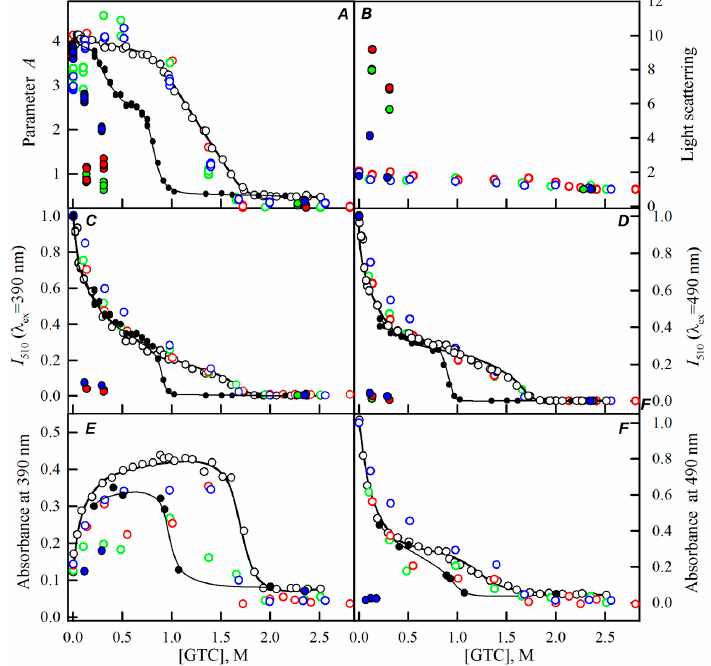
Figure 6. The effect of crowding agent Ficoll-70 on the conformational changes of sfGFP induced by GTC. For more details see the legend of Figure 2. Applied concentrations of Ficoll-70 were 8% (blue circles), 20% (green circles), and 30% (red circles). Denaturation dependencies of all registered characteristics of sfGFP in the presence of all tested concentrations of Dextran-70 (Figure 5) and Ficoll-70 (Figure 6) coincided with the unfolding curves of sfGFP in the absence of crowding